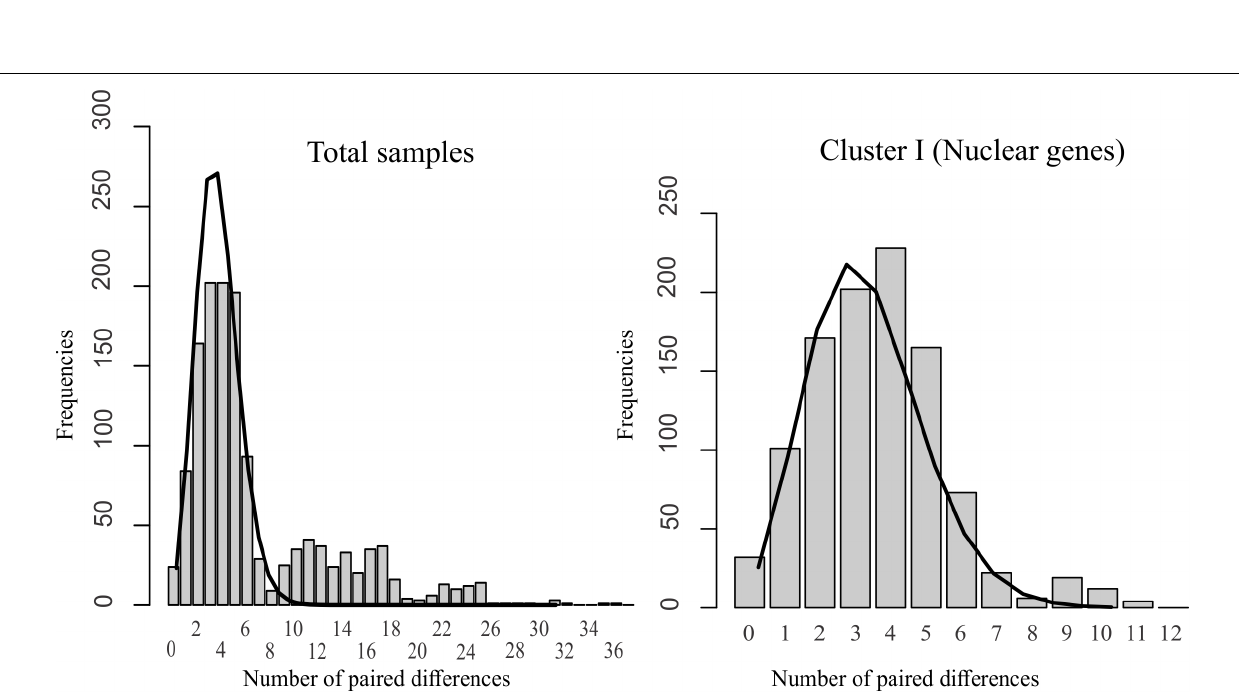
Frontiers in Ecology and Evolution |